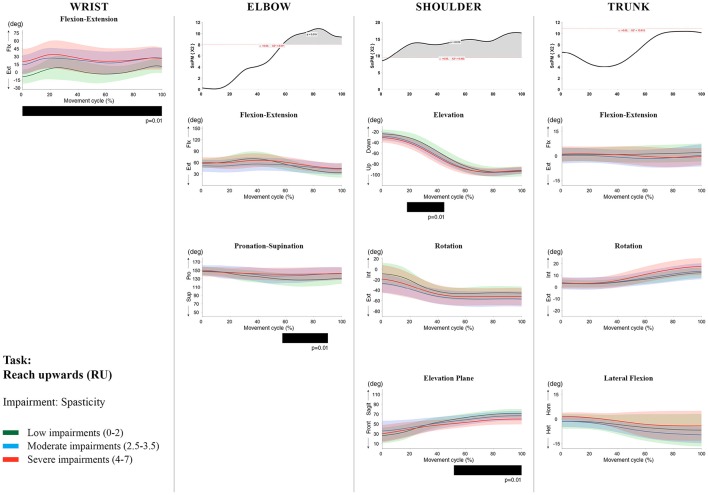
Impact of spasticity on UL movement patterns in children with uCP during the RU task for all joint angles. Each column corresponds to a joint (from left to right: wrist, elbow, shoulder, and trunk). The top image of each column is the SPM output of the vector field analysis (non-parametric Canonical Correlation Analysis test, except for the wrist, where a non-parametric linear regression was computed). For visualization purposes, kinematic data was grouped according to the level of motor impairments, i.e., spasticity total score: low impairments (score between 0 and 2, i.e., values above percentile 75), moderate impairments (score between 2.5 and 3.5, i.e., values between percentile 25 and 75), and severe impairments (score between 4 and 7, i.e., values below percentile 25). Below, mean (bold line) and standard deviation (translucent area) of the low impairments (green), moderate impairments (blue), and severe impairments (red) of each vector component and the respective post-hoc SPM{t} output. The black bar under each kinematic profile indicates clusters of significant influence of the impairment level on the kinematic variable.